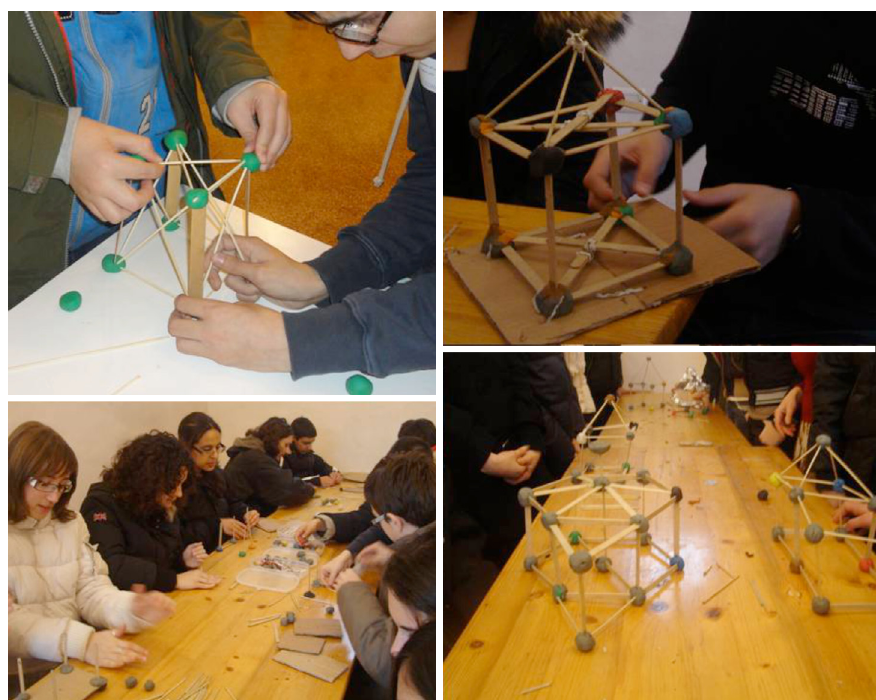
Figure 4. Laboratory activities of “Scientists as a game”: Let’s try to build our own house . Children chal- lenge their abilities to find the best earthquake-proof